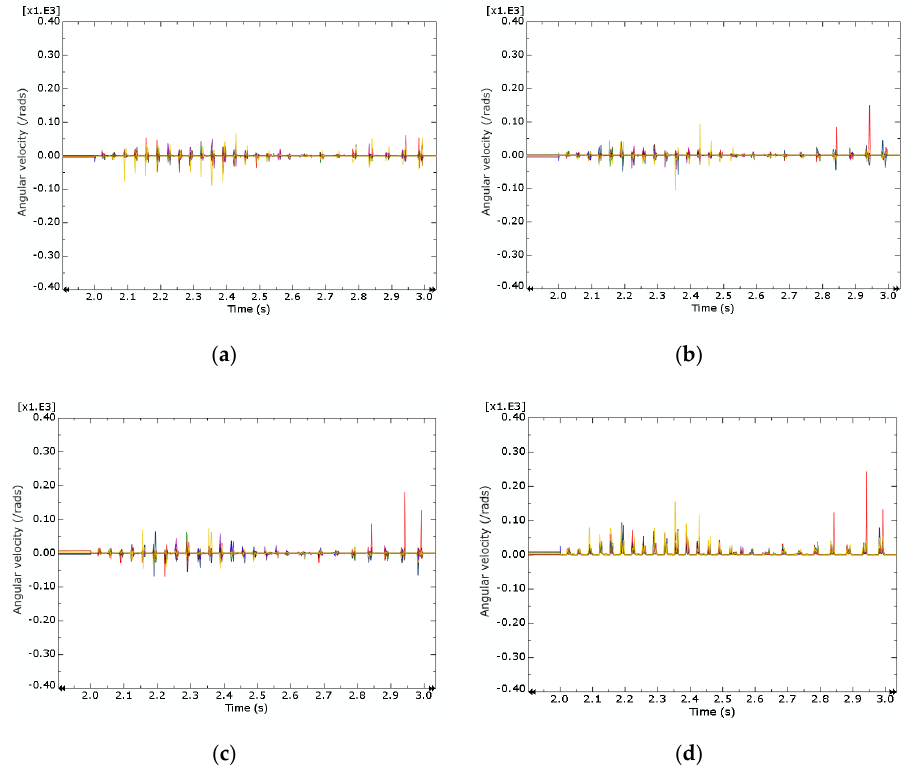
Figure 11. Angular velocity of AC 11 aggregate with a paving speed of 5 m/min: ( a ) in X-direction; ( b ) in Y-direction; ( c ) in Z-direction; ( d ) combined angular velocity.